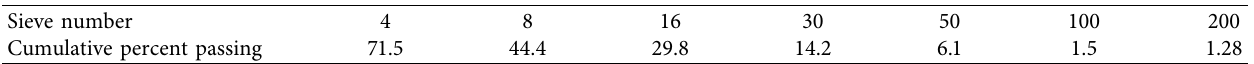
Table 3: Size gradation of the sand used in this study.